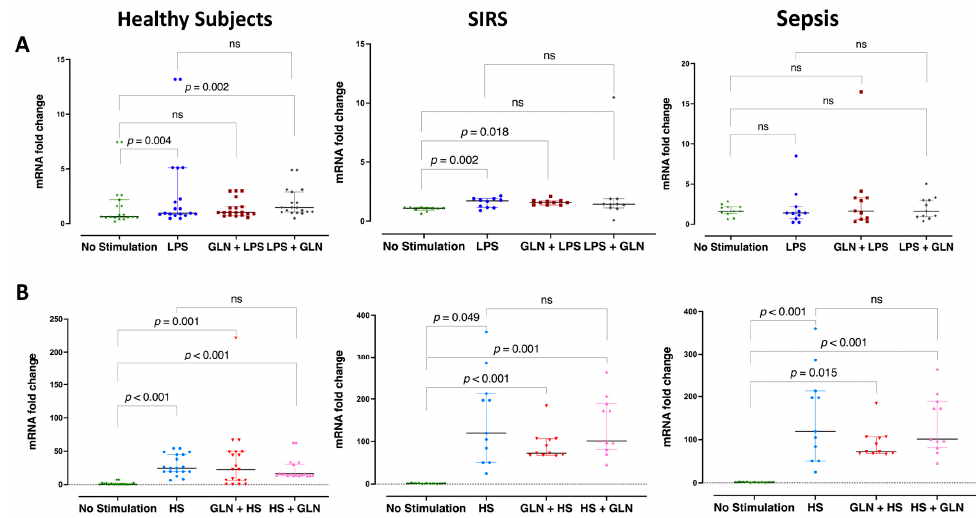
Figure 2. Glutamine effect on heat shock protein 90 α (HSP90 α ) relative mRNA expression in peripheral blood mononuclear cells (PBMCs) within 2 h of LPS or HS stimulation. ( A ) LPS increased the HSP90 α mRNA expression in the PBMCs of healthy subjects and patients with SIRS (trauma) but not in patients with sepsis. Glutamine 1 h before (GLN + LPS) or after (LPS + GLN) stimulation did not alter any induction effect of LPS on the mRNA gene expression of PBMCs in all groups ( B ).